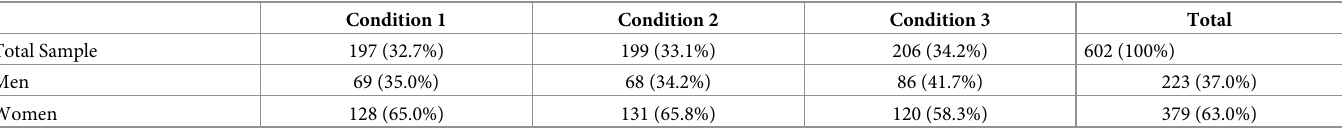
Table 1. Sample distribution for experimental